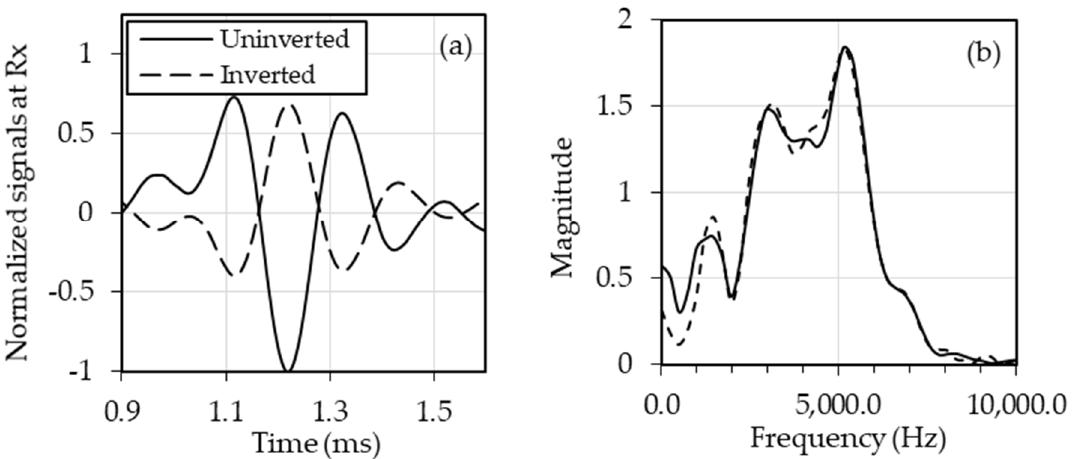
Figure 1. ( a ) Typical time history recorded at the Bender Element (BE) receiver (Rx) and ( b ) Fourier spectra of receiver signals.